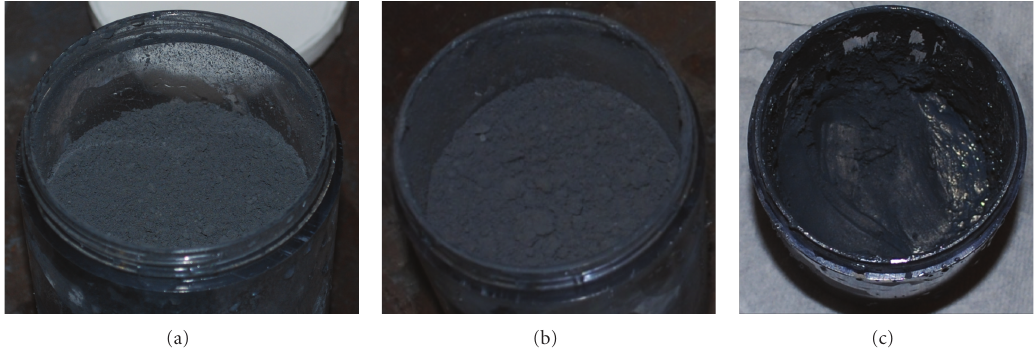
Figure 2: Images of various stages of mixing in 7.6 cm (3 (cid:4)(cid:4) ) diameter jar: (a) mixing consistency after first cycle; (b) mixing consistency after second cycle; (c) mixing consistency after final